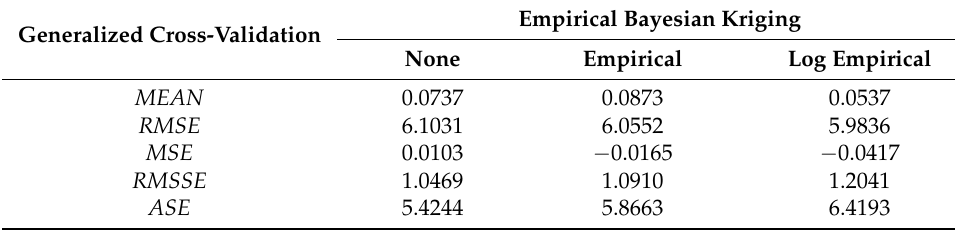
Table 5. Comparison of different empirical Kriging interpolation methods.